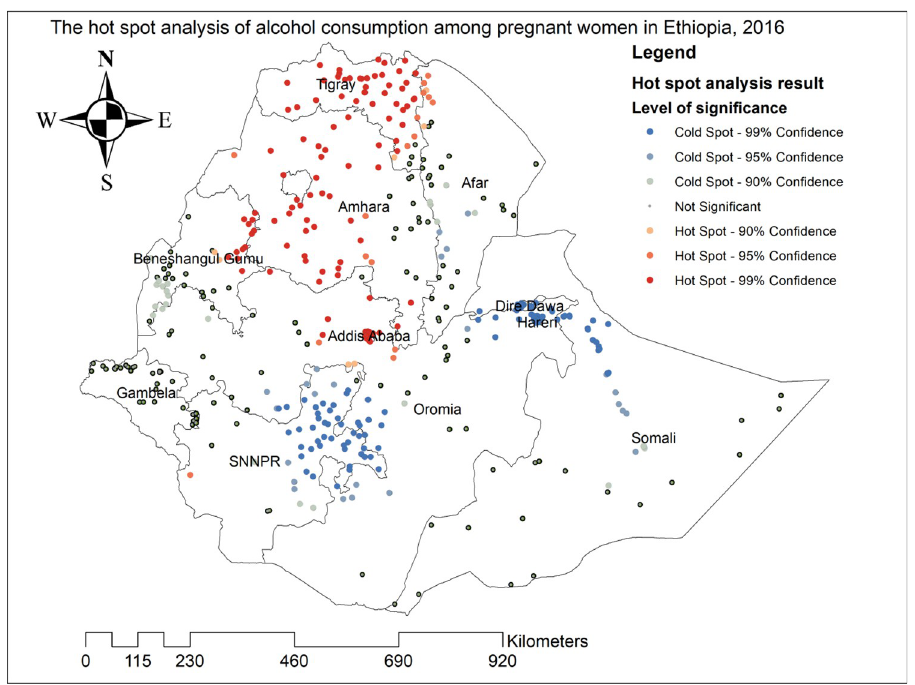
Fig 4. The Hot spot analysis of alcohol consumption among pregnant women in Ethiopia, 2016.